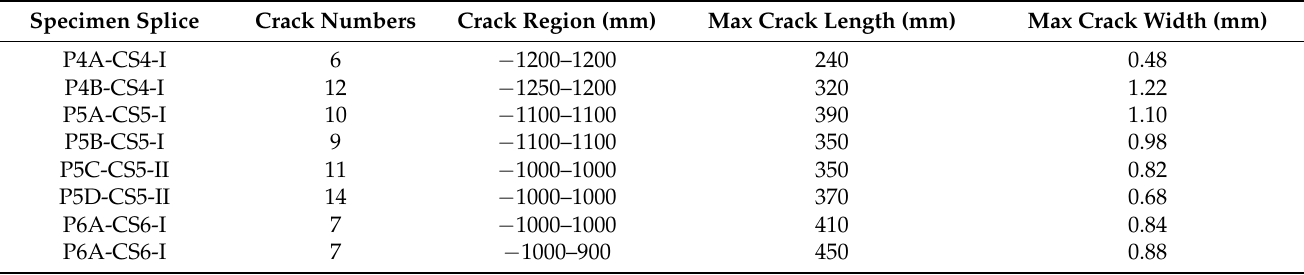
Figure 10. Crack distribution of Specimens: ( a ) P4*-CS-I, ( b ) P5*-CS5-I, ( c ) P5*-CS5-III, ( d ) P6*-CS6-I. Table 6. Crack number and regions.